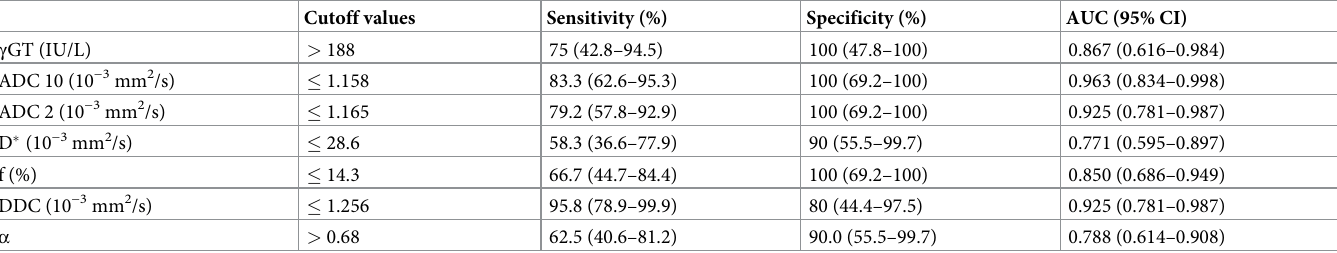
Table 3. Diagnostic performance of parameters for the differentiation of BA from